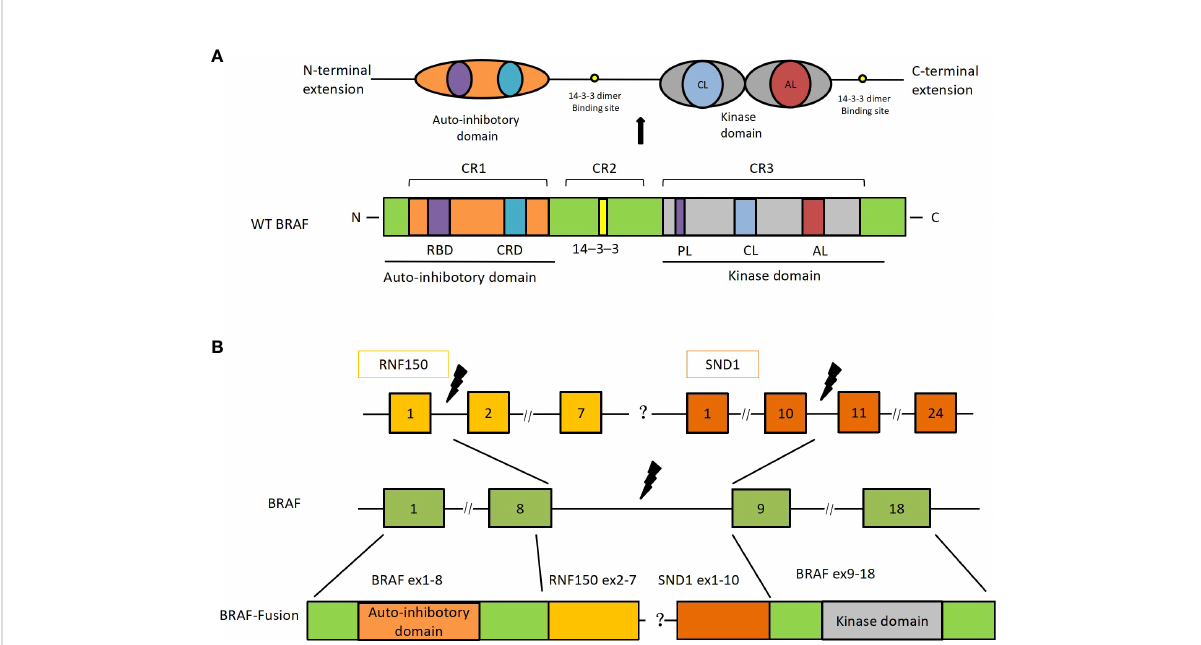
FIGURE 3 SND1-BRAF transcript fusion in metastatic lung adenocarcinoma. (A) The primary structure of BRAF and its functional domains. (B) BRAF- RNF150 and SND1-BRAF fusions. RBD, ras-binding domain; CRD, cysteine-rich domain; PL, phosphate-binding loop; CL, catalytic loop; AL, activation loop; SND, staphylococcal nuclease domain; Ex, exon.